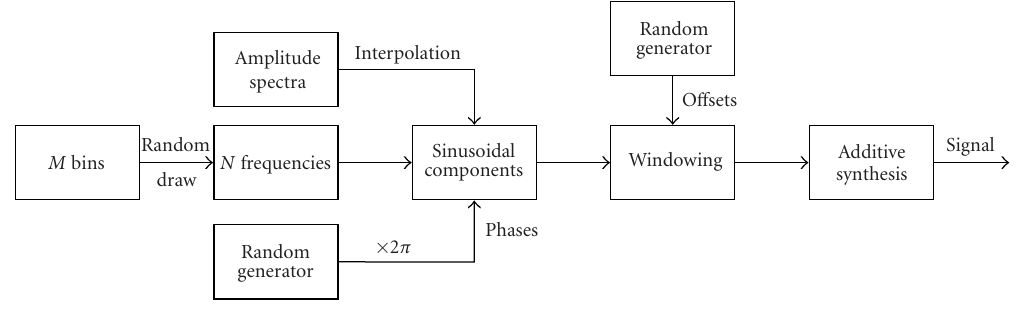
Figure 5: Synthesis block